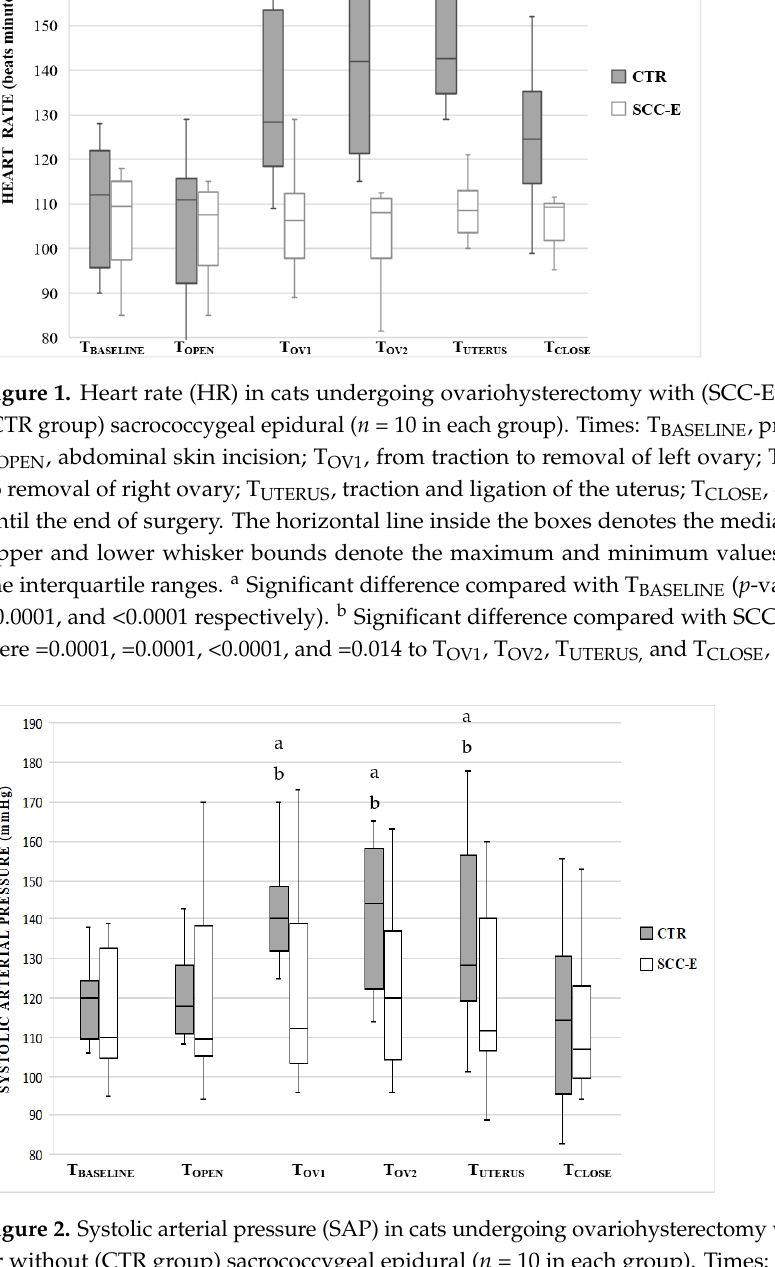
Figure 3. Mean arterial pressure (MAP) in cats undergoing ovariohysterectomy with (SCC-E group) or without (CTR group) sacrococcygeal epidural ( n = 10 in each group). Times: T BASELINE , prior to skin incision; T OPEN , abdominal skin incision; T OV1 , from traction to removal of the left ovary; T OV2 , from traction to removal of the right ovary; T UTERUS , traction and ligation of the uterus; T CLOSE , during celiorraphy until the end of surgery. The horizontal line inside the boxes denotes the median value, while the upper and lower whisker bounds denote the maximum and minimum values. The boxes show the interquartile ranges. a Significant difference compared with T BASELINE ( p- values were 0.018